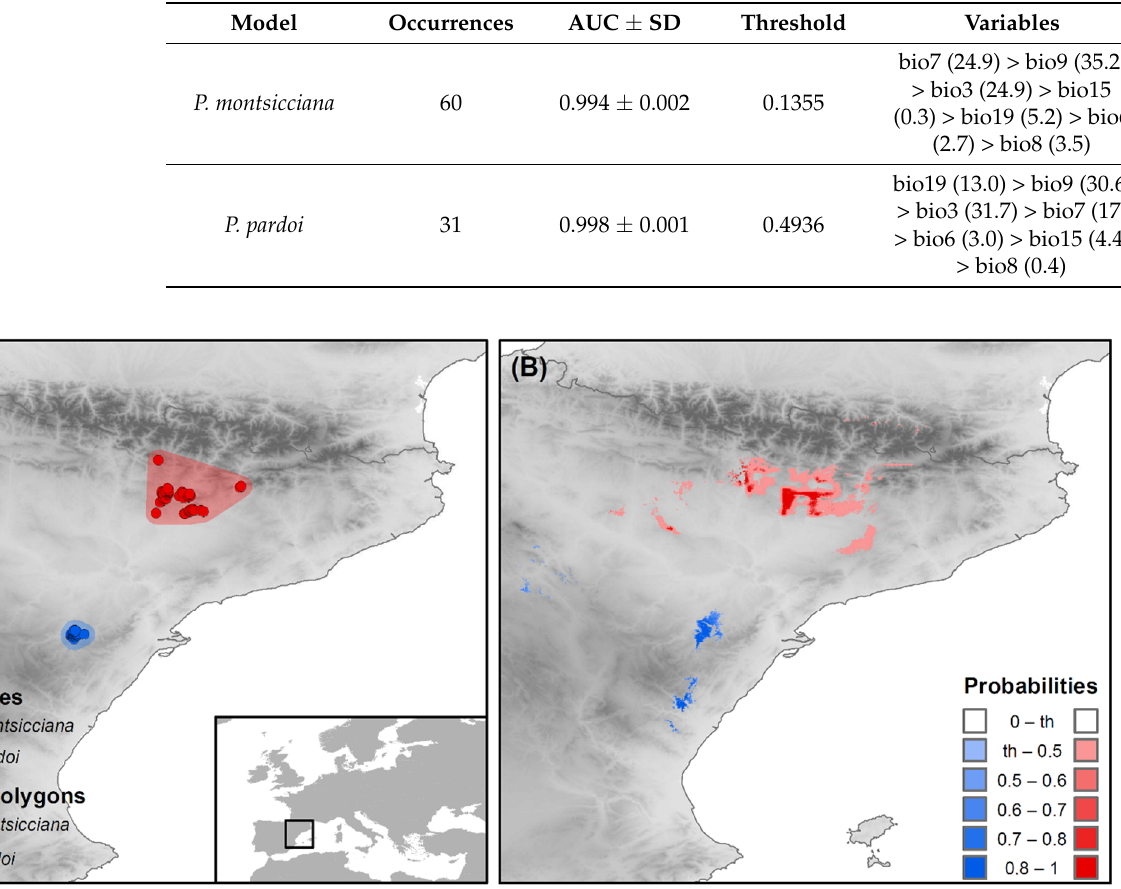
Figure 5. ( A ) Distribution of occurrence records for P. montsicciana and P. pardoi used in the ecological niche modeling analyses and background climates represented by polygon areas used for the PCA-env analysis. ( B ) MaxEnt distribution models delimitated by the maximum training sensitivity plus specificity (MSS) threshold obtained for the both Petrocoptis taxa for the present time.